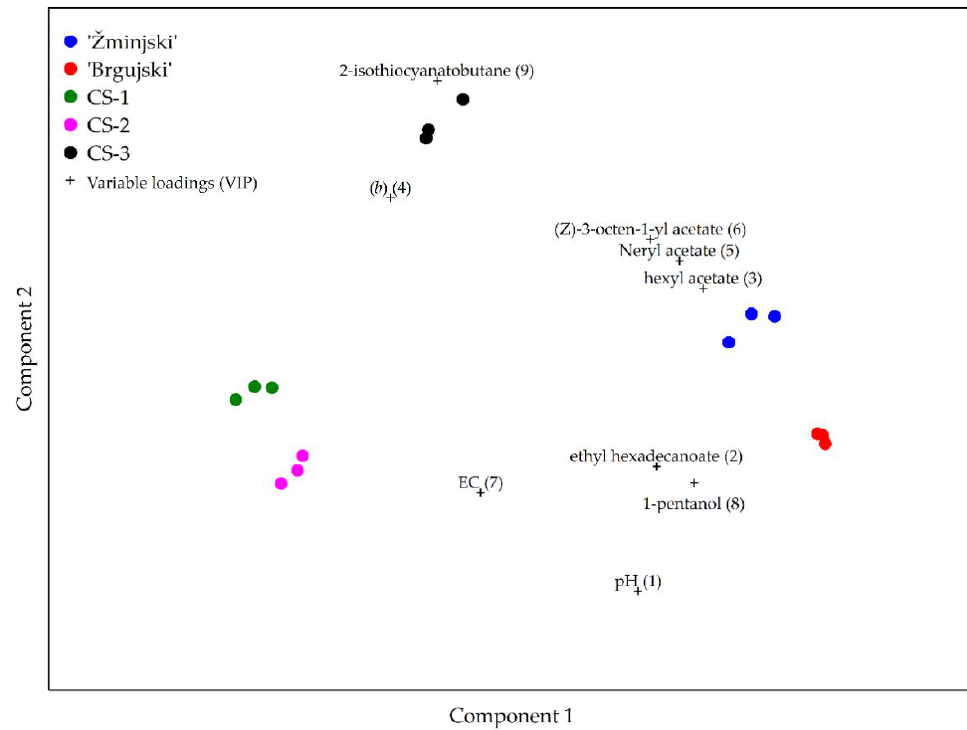
Figure 2. PLS-DA comparison of the investigated sauerkraut samples ‘Brgujski’ and ‘Žminjski’, and commercial sauerkrauts (CS-1, CS-2, and CS-3) .